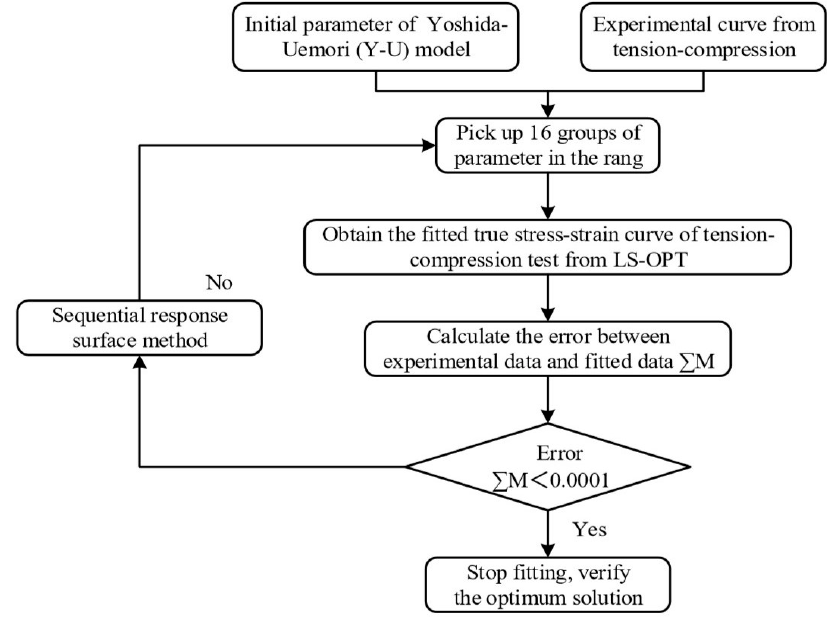
Figure 7. Schematic representation of the material parameter identification process.